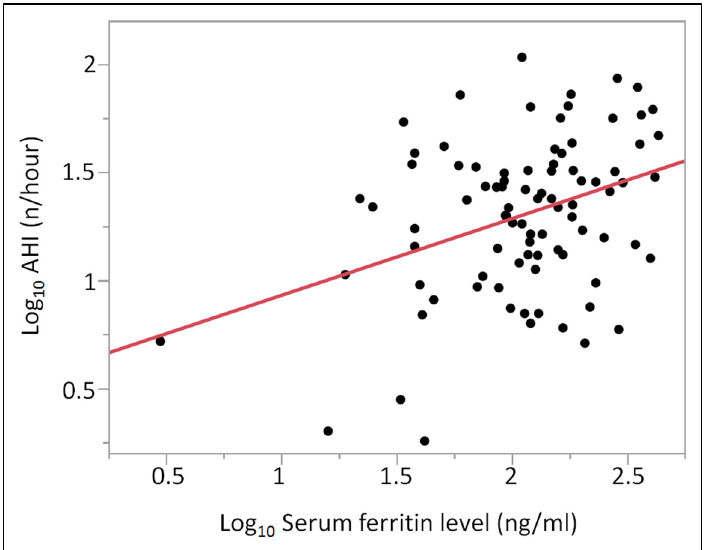
Figure 2. Correlation analysis between log 10 -transformed apnea–hypopnea index and log 10 -transformed serum ferritin level in the entire study cohort. Abbreviation: AHI-apnea–hypopnea index. Pearson correlation identified a significant positive correlation between AHI and serum ferritin level (r = 0.3240, p = 0.0020).